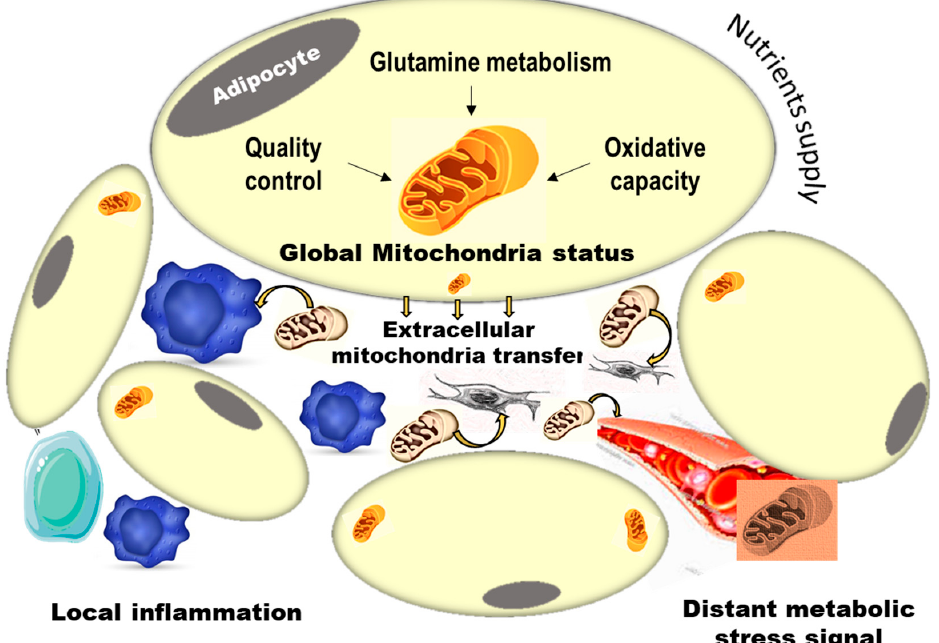
Figure 1. Schematic view of the importance of extracellular mitochondria transfer in adipose tissue metabolic remodeling and systemic metabolic stress signaling. The adipocyte mitochondria global stress status is generated from excessive nutrient supply, defective quality control process and disrupted glutamine metabolism and oxidative capacity of fat cells. This is thought to define the rate of extracellular mitochondria exclusion from fat cells, which is increased in obesity. Subsequent impact of extracellular mitochondria within the adipose tissue micro-environment is expected, by targeting (yellow arrows) immune cells (blue) with consequences on local inflammation, by targeting tissue fibroblasts and progenitors (grey) to orient their fate and differentiation, or by targeting more distant metabolic signaling through the circulation.